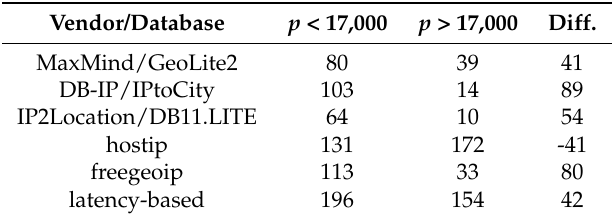
Table 9. Location accuracy—median distance error for cities with population p .